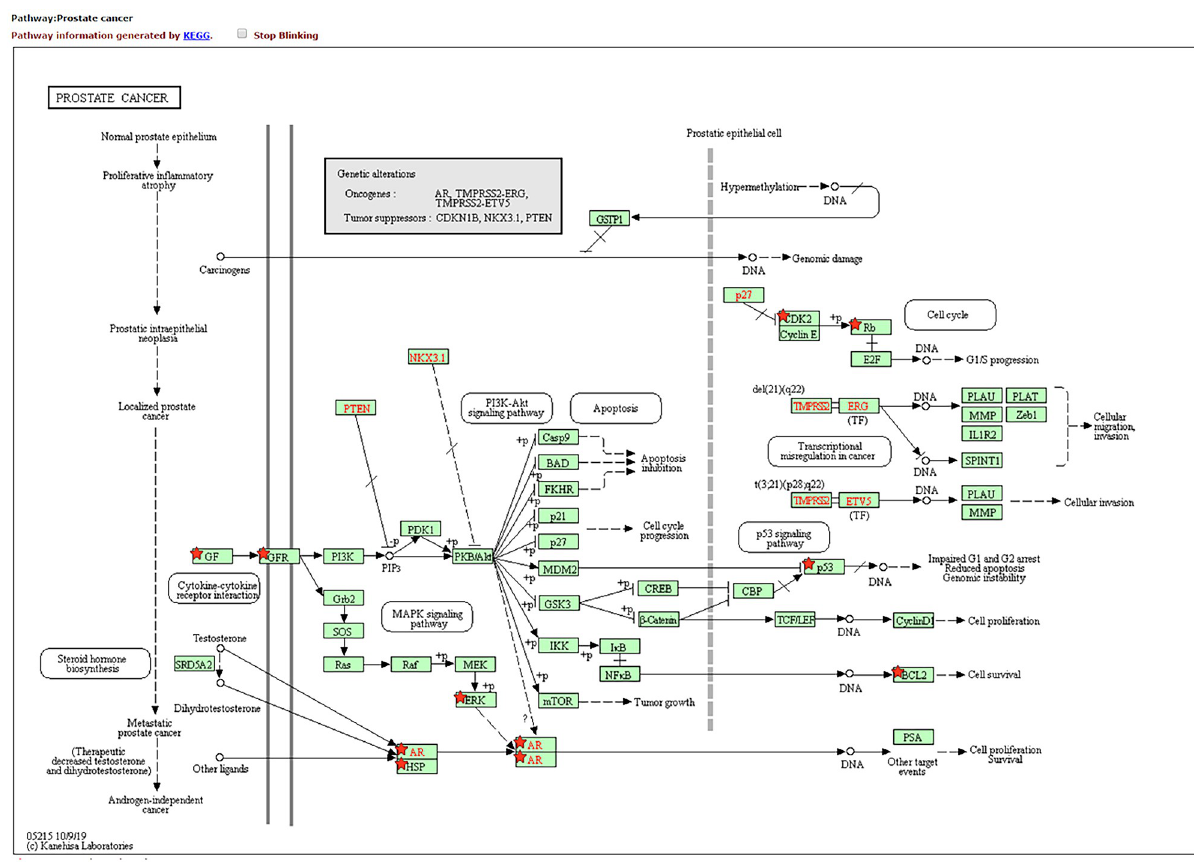
Fig 6. Prostate cancer pathway. Prostate cancer pathway information generated by KEGG. The highlighted part of the pathways and protein nodes related to this research.